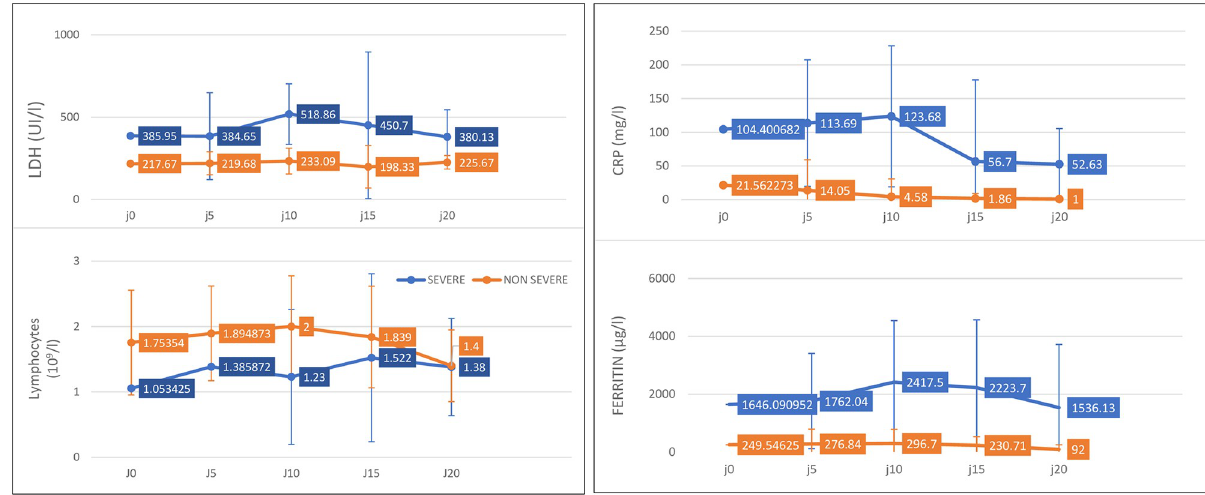
Fig 1. Temporal changes in laboratory markers from illness onset in patients hospitalized with